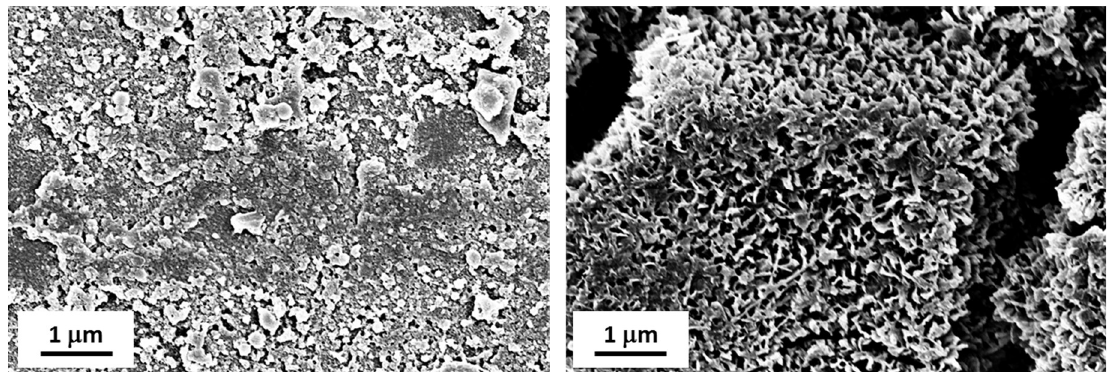
Figure 16. FE-SEM observations of LF slippers after endurance tests in the outer area (“crown”, left ) and in the central area (close to the hole, right ). Scale bars are reported.